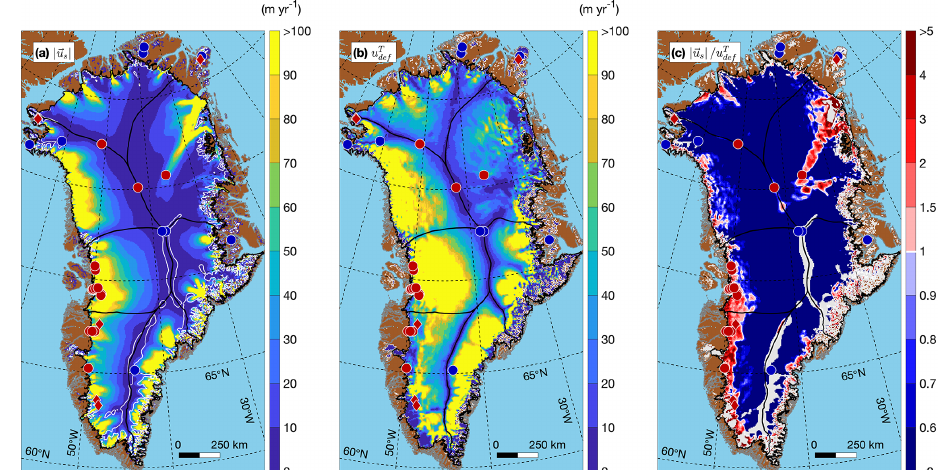
(cid:42) (cid:42) u s | ) across the GrIS. Regions where its relative uncertainty ( ˜ u s / | u s | ) ) assuming an entirely temperate ice column. d (cid:42) u s | ≥ 25% are masked out, and regions